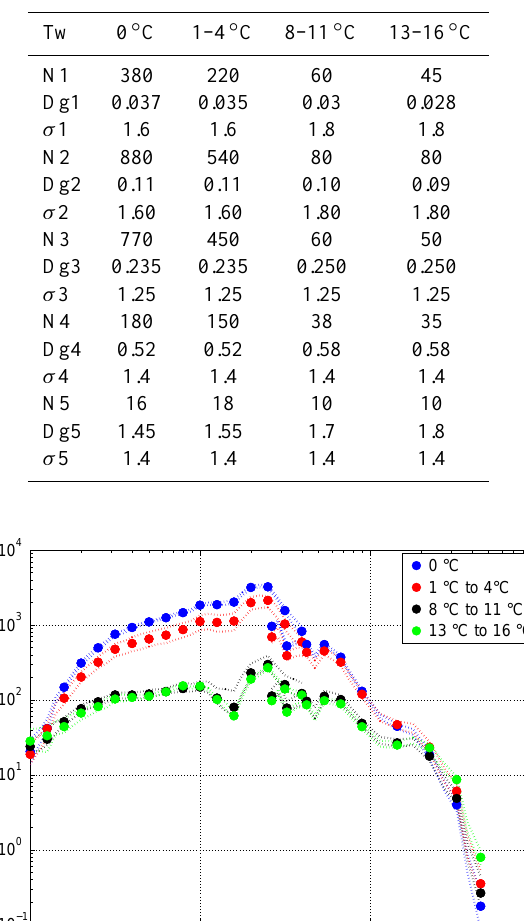
Table 2. Parameters for fitted lognormal aerosol number size dis- tributions with Nx as the number concentration (cm − 3 ), Dgx as the geometric diameter (µm) and σ x as the standard deviation for the different modes and water temperatures ( T w ): 0 ◦ C, 1–4 ◦ C, 8– 11 ◦ C, and 13–16 ◦ C.